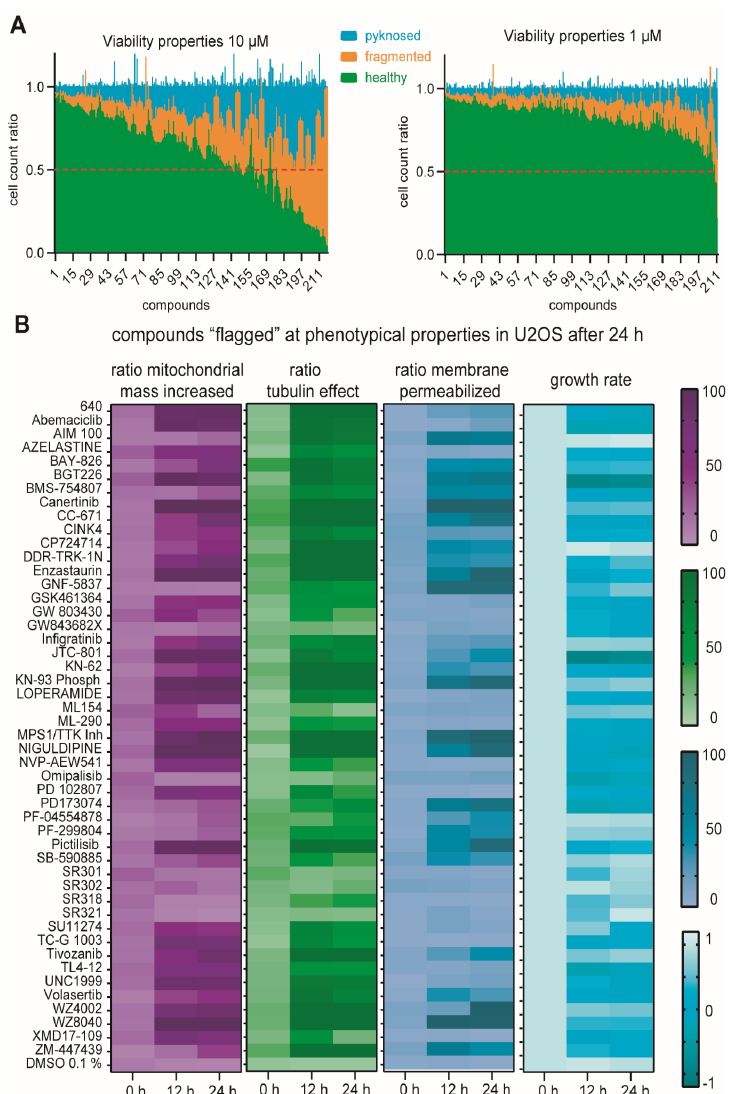
Figure 5. Multiplex Certificates of Chemogenomic Compounds. ( A ) Cell count ratio of different nuclei gating after 24 h of 10 µM and 1 µM of compound exposure (Supplementary Table S8) in U2OS cells. Error bars show SEM of biological duplicates. Healthy nuclei count at 50% (viability threshold) marked as a red line. ( B ) Heat map of phenotypical property ratios (tubulin effect, mitochondrial mass increased and membrane permeabilized) and the growth rate, which was calculated against the non- treated cell number, as described earlier by Hafner et al. [61] of U2OS cells exposed to 49 compounds, that were marked as ‘flagged’ after Multiplex analysis (phenotypical property threshold > 50%). Heat map shows meaning of two biological duplicates. All data are available in Supplementary Table